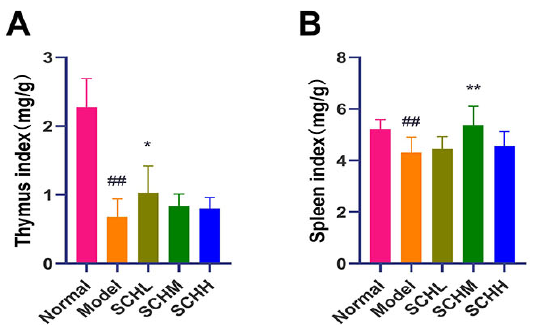
Figure 2. Effects of SCH on the thymus index ( A ) and spleen index ( B ) in immunosuppressed mice. The results are presented as the means ± SD (n = 10). ## p < 0.01 compared with the normal group, * p < 0.05, ** p < 0.01 when compared with the model group.